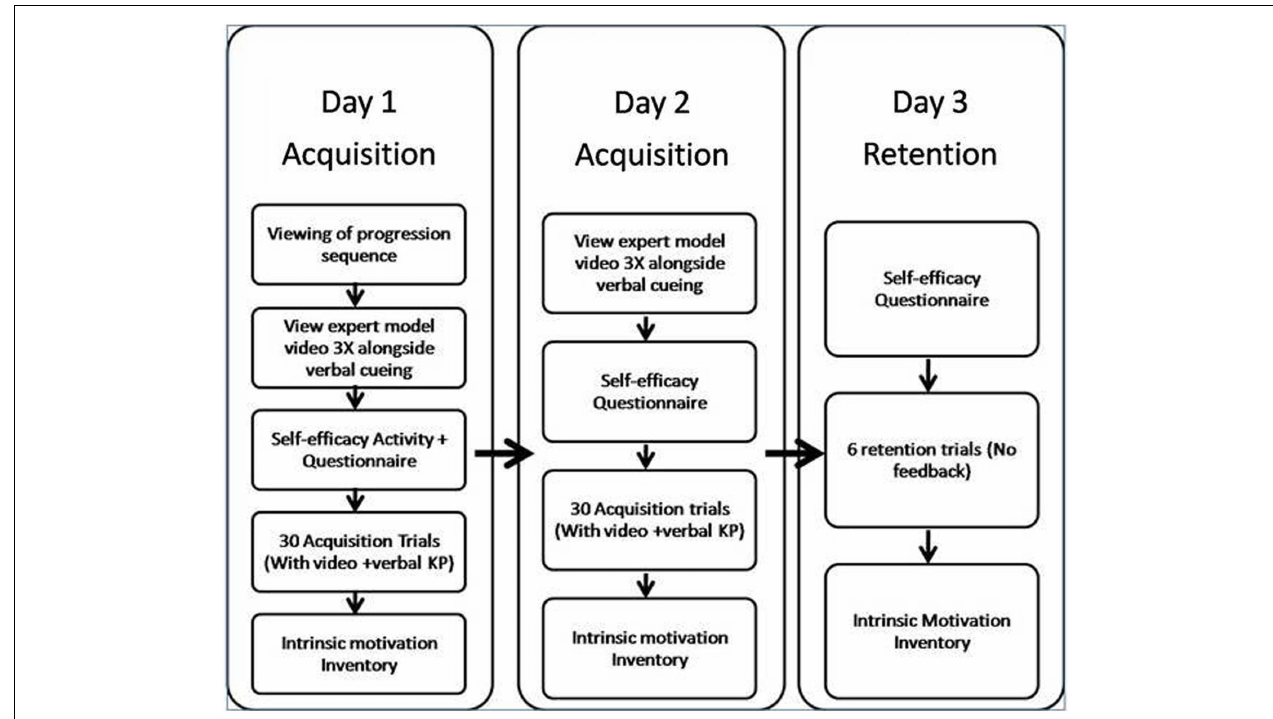
FIGURE 1 | Summary of procedure during the acquisition (day 1–2) and retention (day 3)